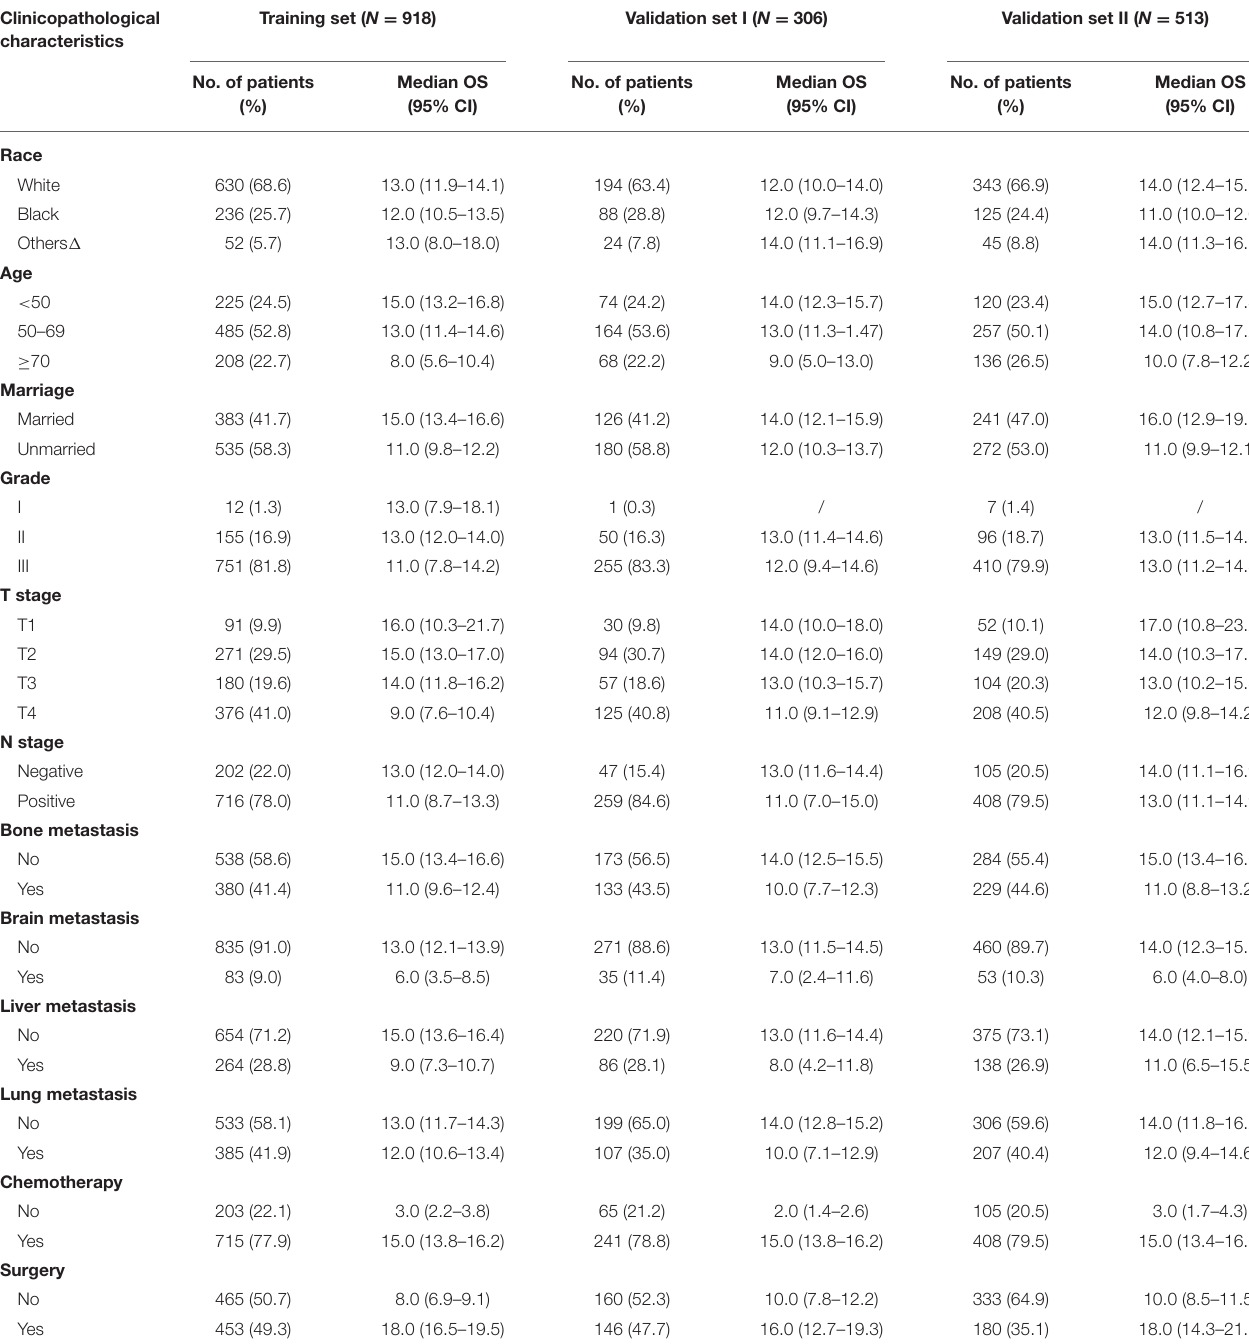
TABLE 1 | Baseline clinicopathological characteristics of the included patients with initially diagnosed metastatic triple-negative breast cancer. Clinicopathological